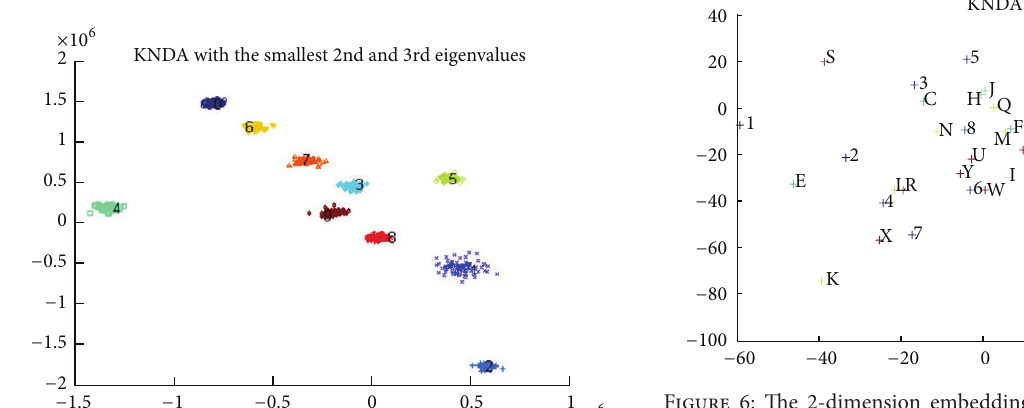
Figure 6: The 2-dimension embedding results by KNDA, using Binary Alphadigits database.